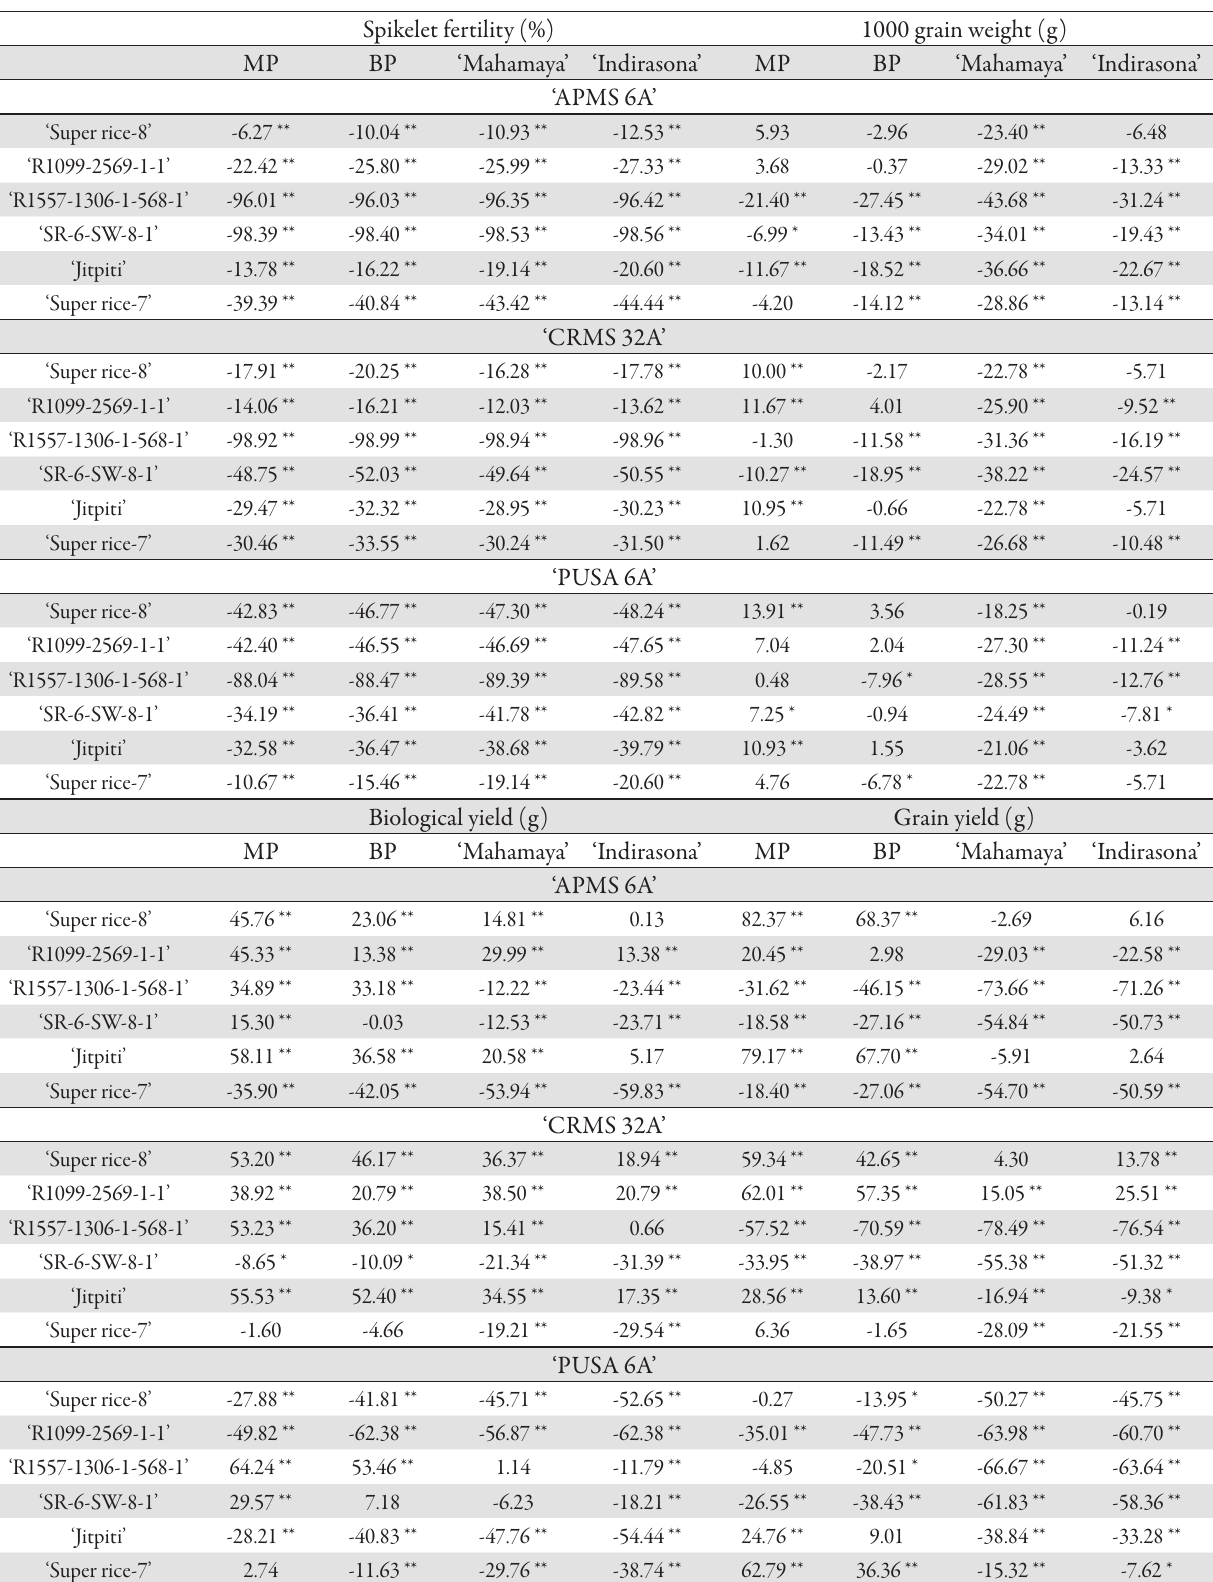
Tab. 3. Percent relative heterosis, heterobeltiosis and standard heterosis for different characters in rice